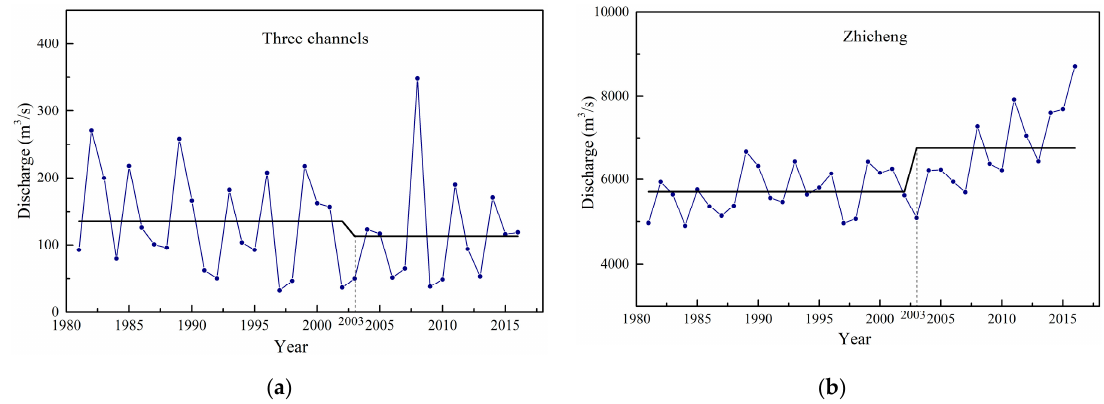
Figure 10. The long term change of the inflow from ( a ) “three channels” ( b ) Yangtze River (Zhicheng station).